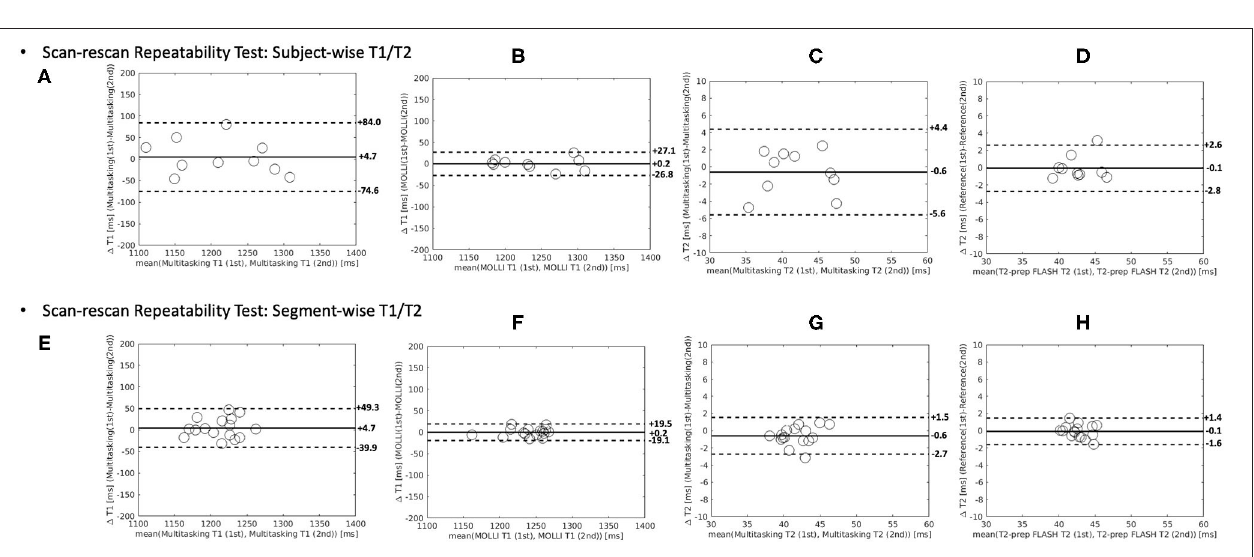
FIGURE 9 | The Bland–Altman plots comparing measurements from 1st and 2nd Multitasking-SMS scans and reference scans in subject-wise T1/T2 (A–D) and segment-wise T1/T2 (E–H) . Multitasking-SMS T1/T2 repeatability analysis are shown in (A,C,E,G) . Reference T1/T2 repeatability analysis are shown in (B,D,F,H) . The dash lines indicate the 95% limits of agreement and the solid line indicates mean